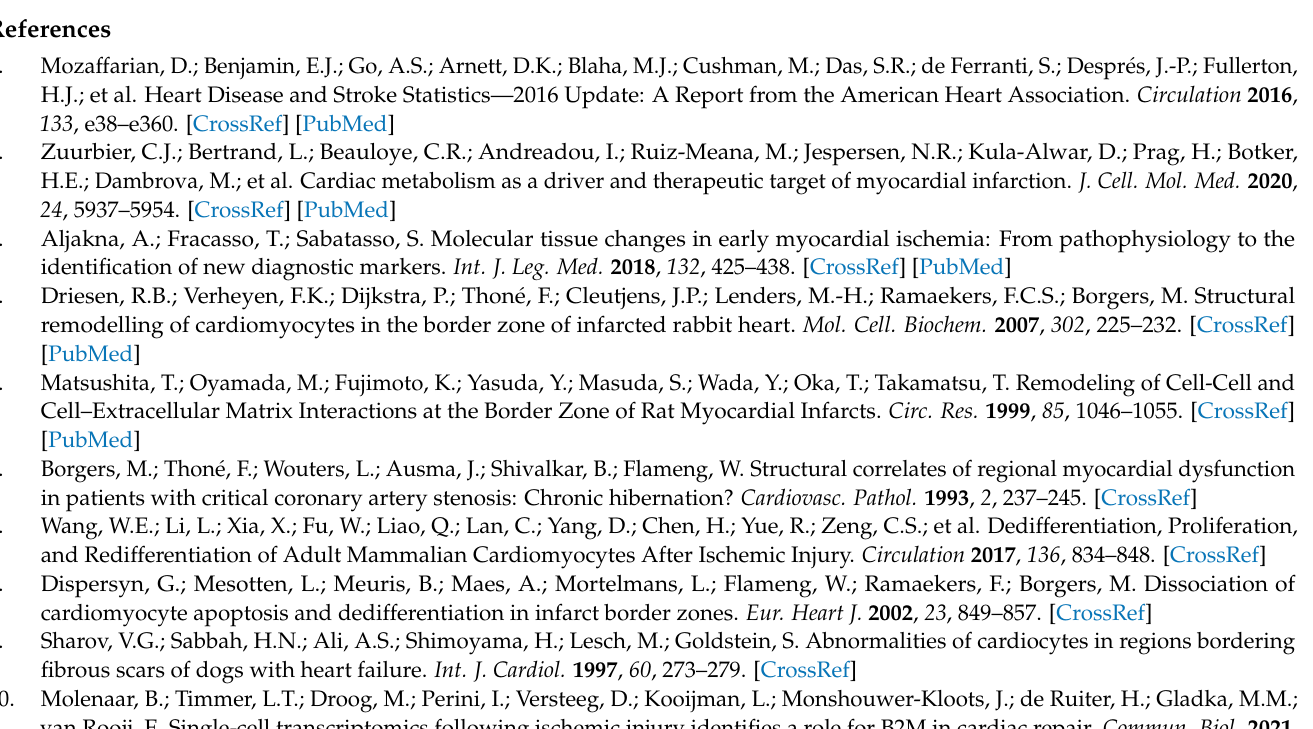
at 7 dpi in RM and BZ. Scale bar, 10 µ m. Dpi, days post infarction; RM, remote myocardium; BZ, border zone. Figure S4: UCSC genome browser views of ( A ) Vldlr , ( B ) Fabp3 , ( C ) Hk1, ( D )